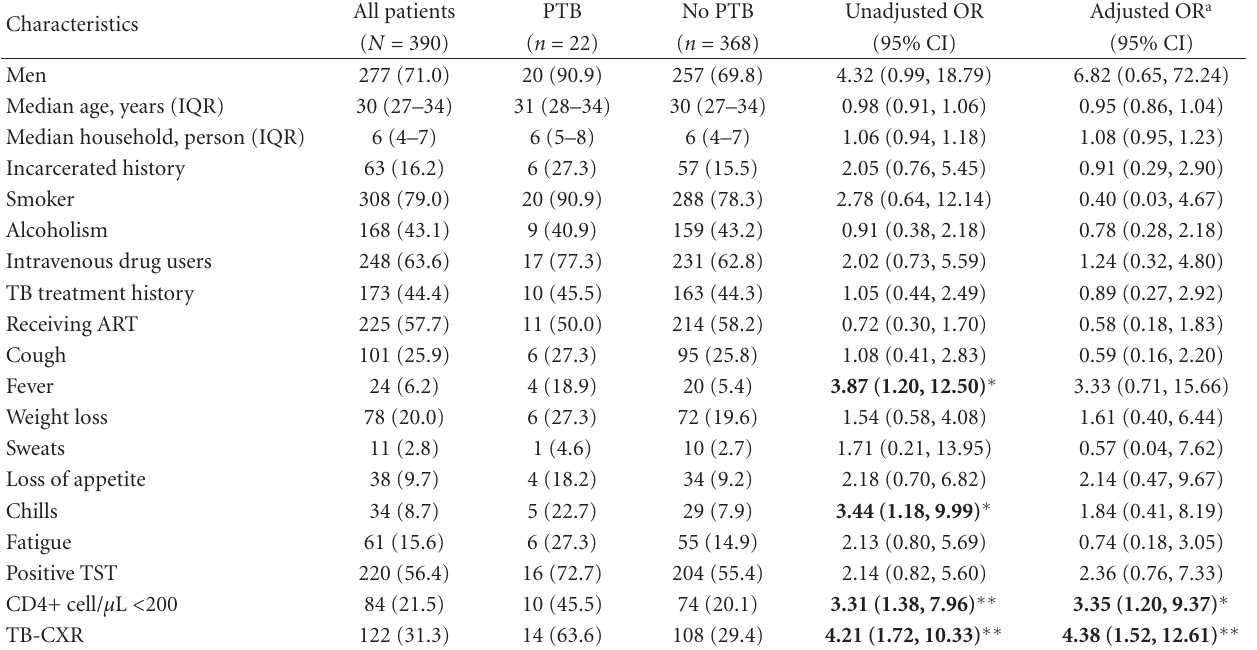
Table 1: Potential predictors for pulmonary tuberculosis in 390 HIV-infected persons having sputum smears negative for acid fast bacilli.